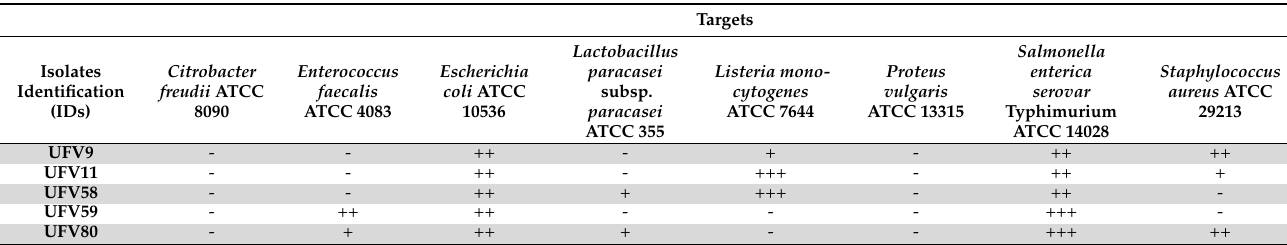
Table 1. In vitro inhibitory activity of selected streptococci obtained from the bovine rumen.